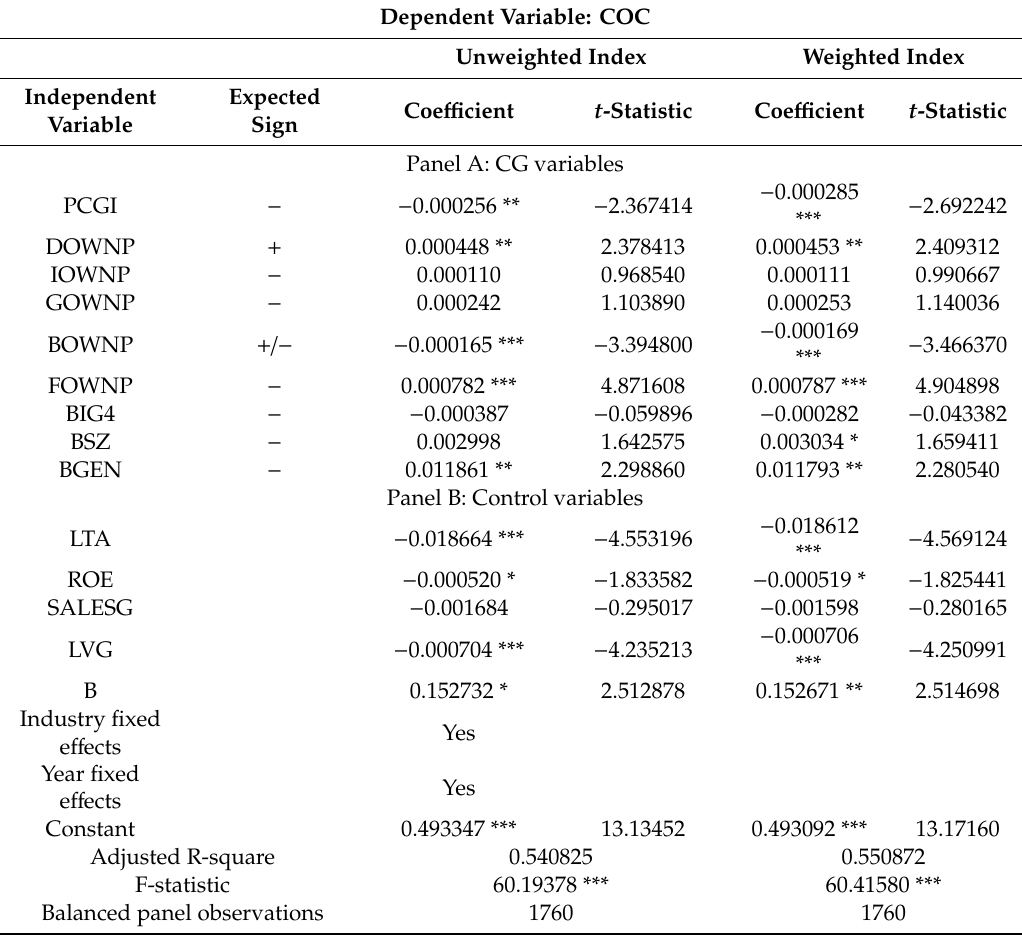
Table 3. Results based on weighted CG